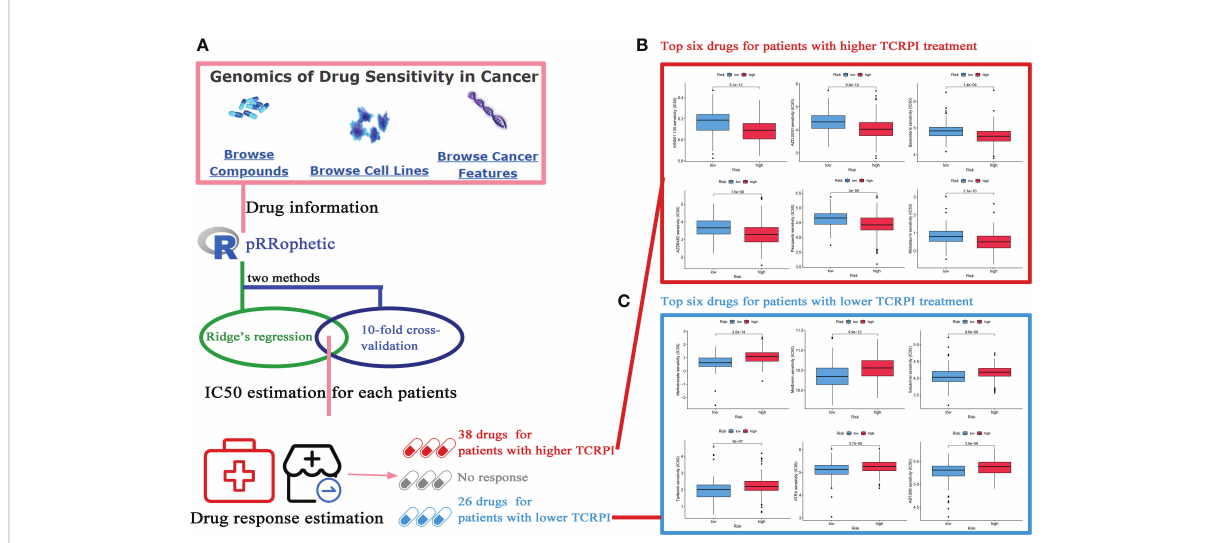
FIGURE 9 Potential drugs for BLCA treatment exploration. (A) The fl ow diagram of the IC50 estimation and drug sensitivity estimation (38 drugs for patients with a higher TCRPI, 26 drugs for patients with a lower TCRPI. (B) The top six drugs for BLCA patients with higher TCRPI treatment. (C) The top six drugs for BLCA patients with lower TCRPI